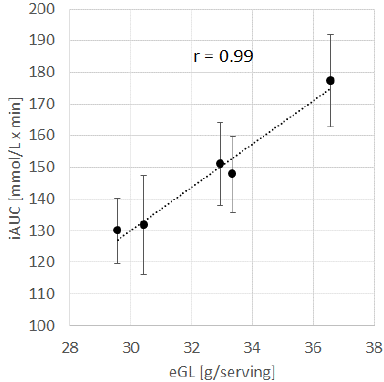
Figure 4. Relationship between the model-predicted eGL and the measured in vivo 120 min incre- mental area under the curve (iAUC) for the 5 infant cereal prototypes of study B, each of them being represented by a black dot (values are mean ± SE).